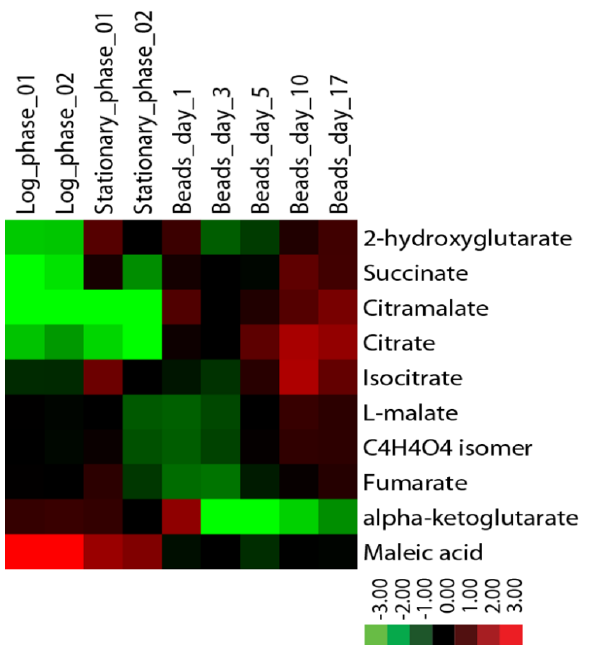
FIGURE 5: Levels of citric acid cycle metabolites in continuously- fed encapsulated yeast differ from planktonic yeast in exponen- tial and stationary phases. Metabolites were extracted from flash- frozen cell pellets grown in batch or in continuous culture as indi- cated [172] and analyzed by LC-MS using a reversed phase meth- od. Metabolite levels were normalized to the quantity of input cells, and displayed as a log2 fold change centered around the median value for each